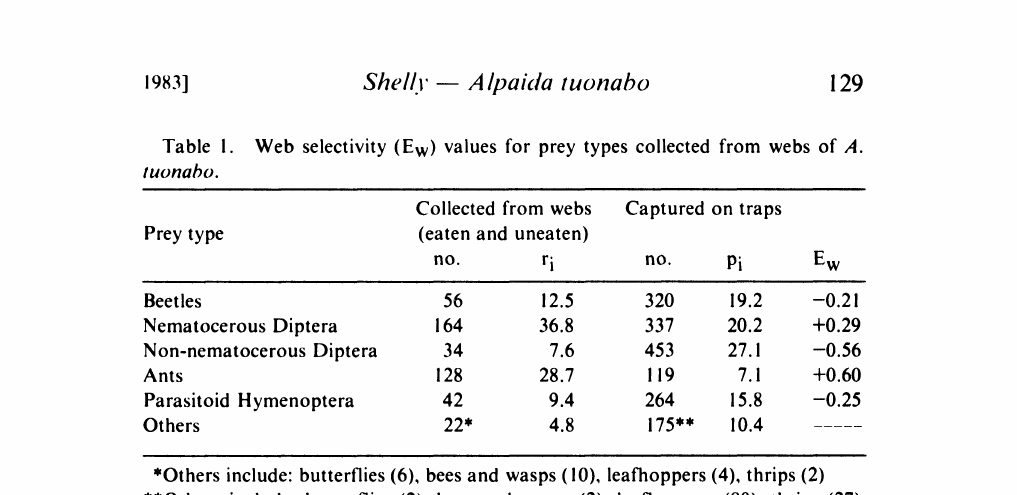
Table I. Web selectivity (Ew) values for prey types collected from webs of A. tuonabo. Collected from Prey type